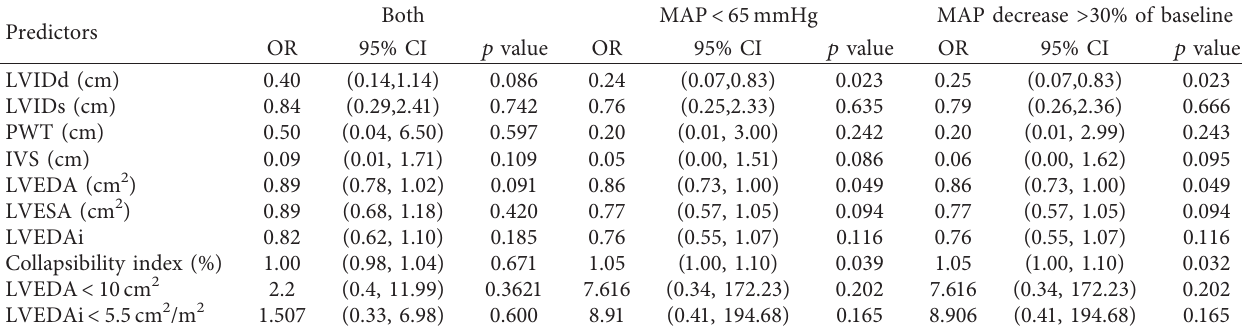
Table 3: Unadjusted logistic regression models including one predictor at a time ( n � 63). Both MAP < Predictors